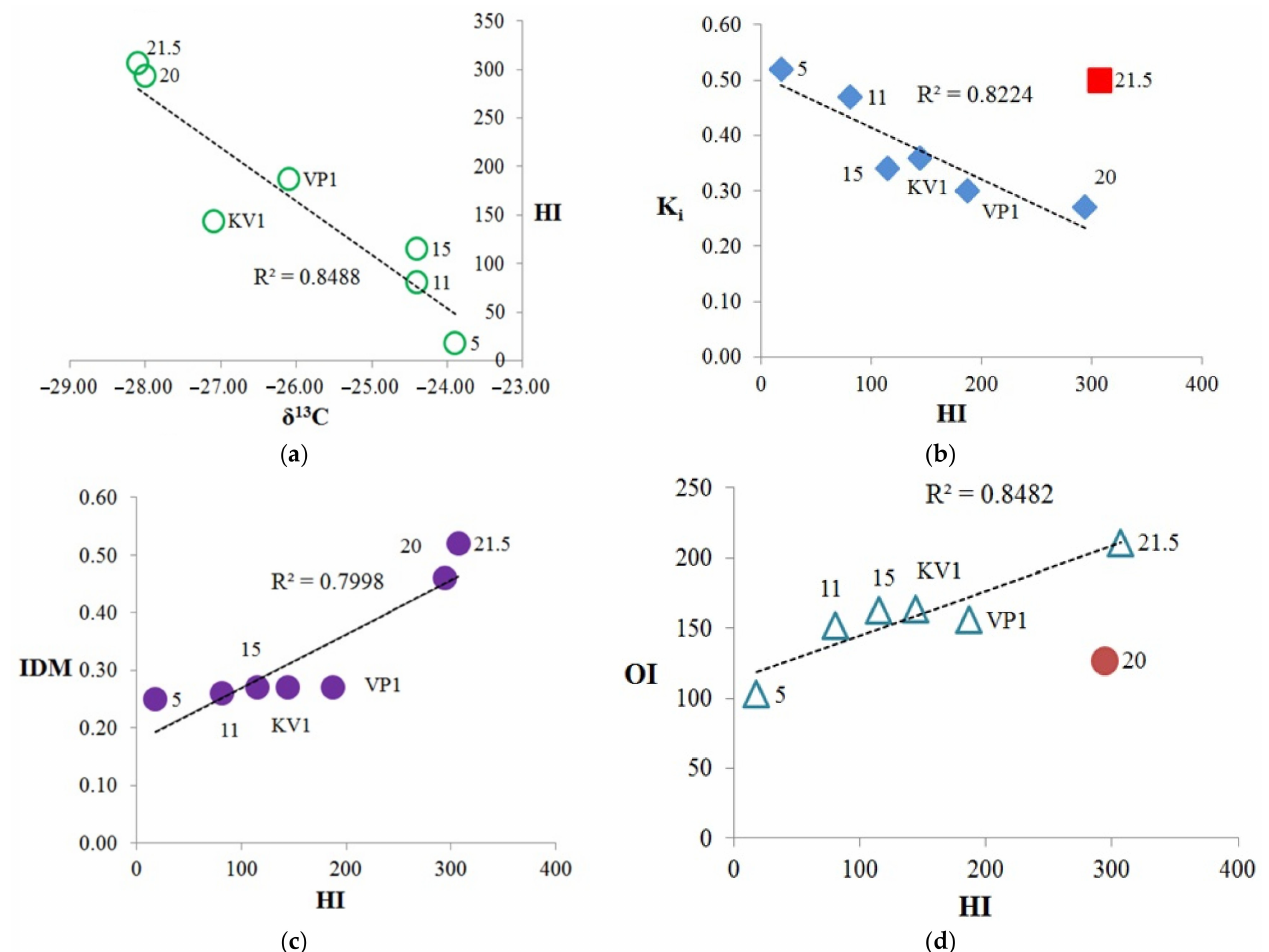
Figure 7. The relationships between Rock-Eval parameters, isotopic composition, and K i : ( a ) isotopic composition ( δ 13 C) vs. hydrogen index (HI); ( b ) K i vs. hydrogen index (HI), with sample “21.5” falls out from trend, K i represents the (Pr + Ph)/(nC 17 + nC 18 ) ratio; ( c ) diagenetic maturity index (IDM) vs. HI; ( d ) oxygen index (OI) vs. HI, while sample “20” falls out from